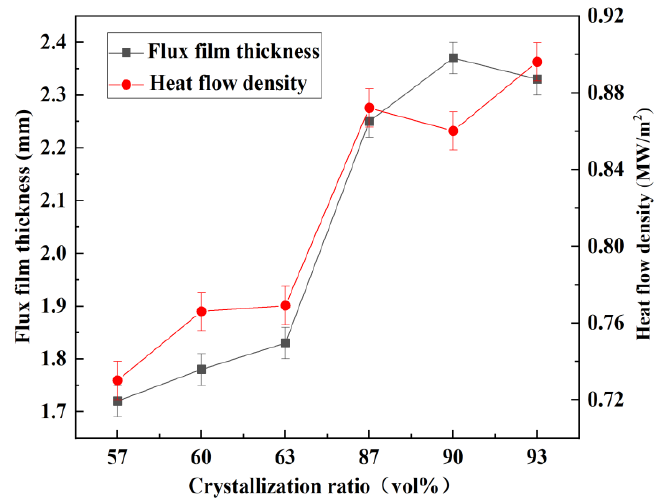
Figure 10. Relationship between the heat flow density and mineralogical structure of flux films.